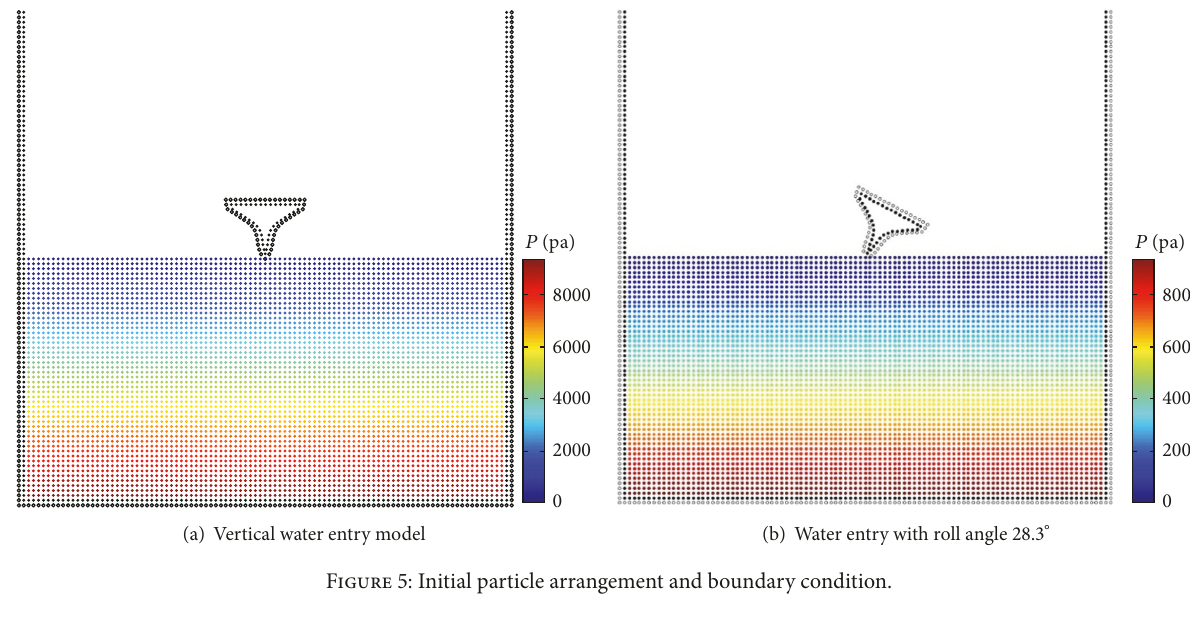
Figure 5: Initial particle arrangement and boundary condition.